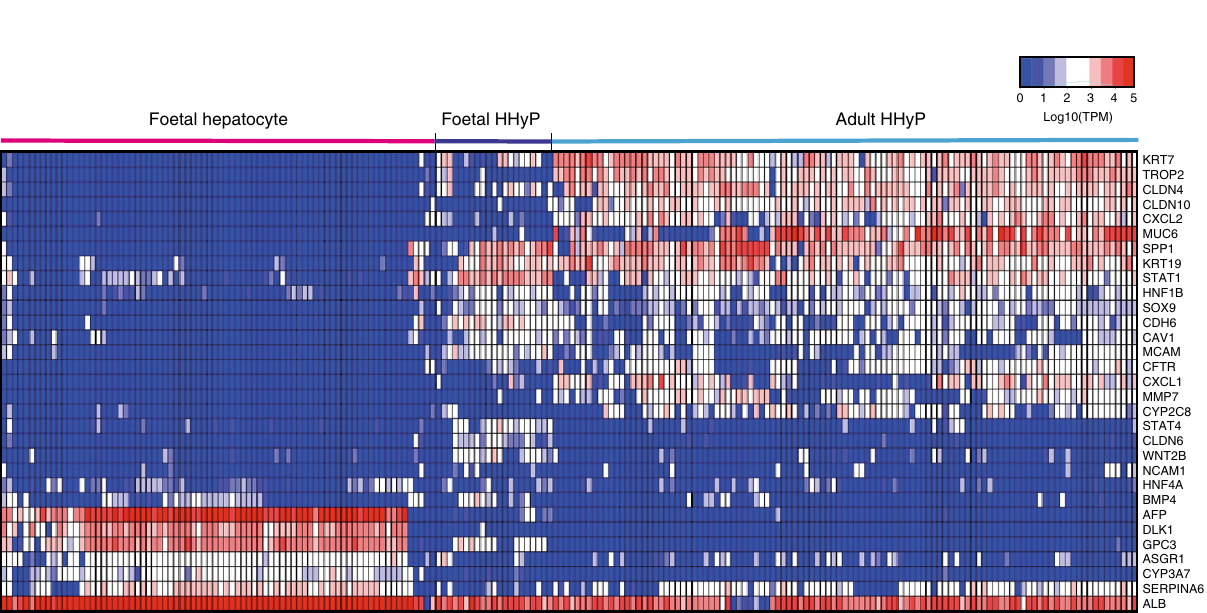
Fig. 1 ScRNA-Seq analysis of foetal and adult human liver. a Overview of foetal and adult liver FACS strategy. b 2D t-SNE visualisation of single cells isolated from foetal and adult human liver coloured by FACS gating population, shaped by tissue source. c Transcript expression of selected markers overlaid on the 2D t-SNE space of human liver scRNA-seq analysis. Expression is Log10(TPM). d Heat maps of selected gene expression in mature hepatic, foetal hepatic, hybrid hepatobiliary progenitor (HHyP) and mature cholangiocyte cell populations. Gene expression in Log10(TPM). Mean gene expression of cells in each cluster is plotted, HHyP population = 138 cells, mature biliary epithelial cell (BEC) = 9 cells, mature hepatocytes = 226 cells, foetal hepatocytes = 82 cells. e 2D t-SNE visualisation of single cells isolated from foetal and adult human liver coloured by cell type. Phenotypic labelling based on transcriptional analysis. f Proportions of tissue sample contributions from adult liver (AL) and foetal Liver (FL) in each phenotypically labelled cell type as a percentage of the total population. t-SNE t-distributed stochastic neighbour embedding, TPM transcripts per million, FACS fl uorescence-activated cell